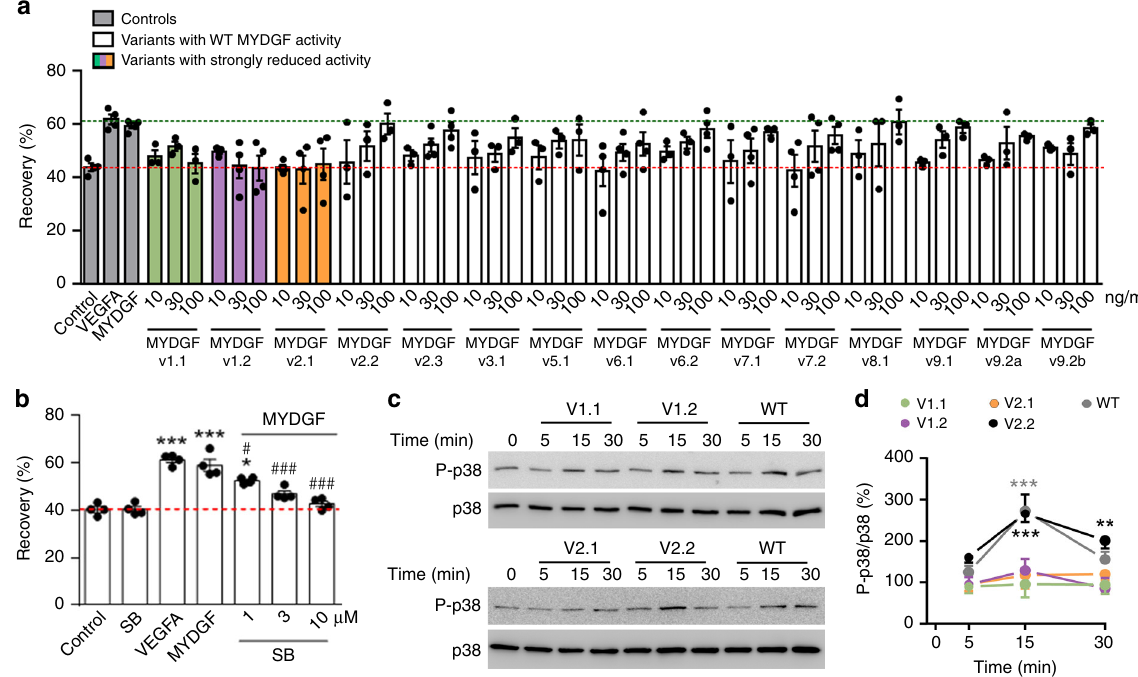
Fig. 3 MYDGF patch mutations and effects of wild-type MYDGF and variants on p38 activation in HCAECs. a Migration assay quantifying HCAEC monolayer recovery 16 h after scratch injury in the absence (control) or presence of vascular endothelial growth factor A (VEGFA, 50 ng/ml), wild-type MYDGF (100 ng/ml) or MYDGF mutants (at indicated concentrations). Biologically active MYDGF mutants are colored black, while the inactive mutants are colored green, purple and orange (SEM error bars). b MYDGF (100 ng/ml) induced endothelial cell migration is mediated by p38-MAPK. This effect can be reversed in a dose-dependent manner upon treatment with a p38 selective kinase inhibitor (SB203580) (10 µ M). VEGFA (50 ng/ml) was used as a positive control (*** P < 0.001, * P < 0.05 vs. Control; ### P < 0.001, # P < 0.05 vs. MYDGF; SEM error bars). c Western blot analysis of MYDGF wild-type and variant stimulated HCAECs. d Densitometric analysis of Western blot in c . P-p38 signals were referenced to total p38 signals and summarized. Wild- type MYDGF and v2.2 show similar P-p38/p38 ratios, while v1.1, v1.2 and v2.1 show a reduction of p38 phosphorylation (*** P < 0.001, ** P < 0.01 vs. Control; SEM error